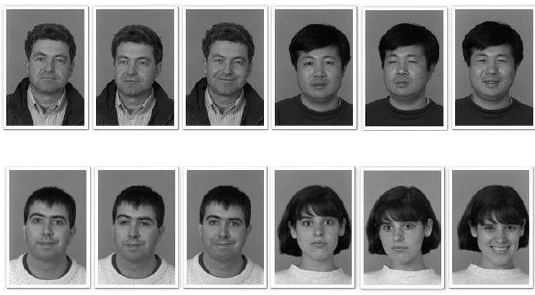
Figure 6. Some samples from the face recognition technology (FERET) database.